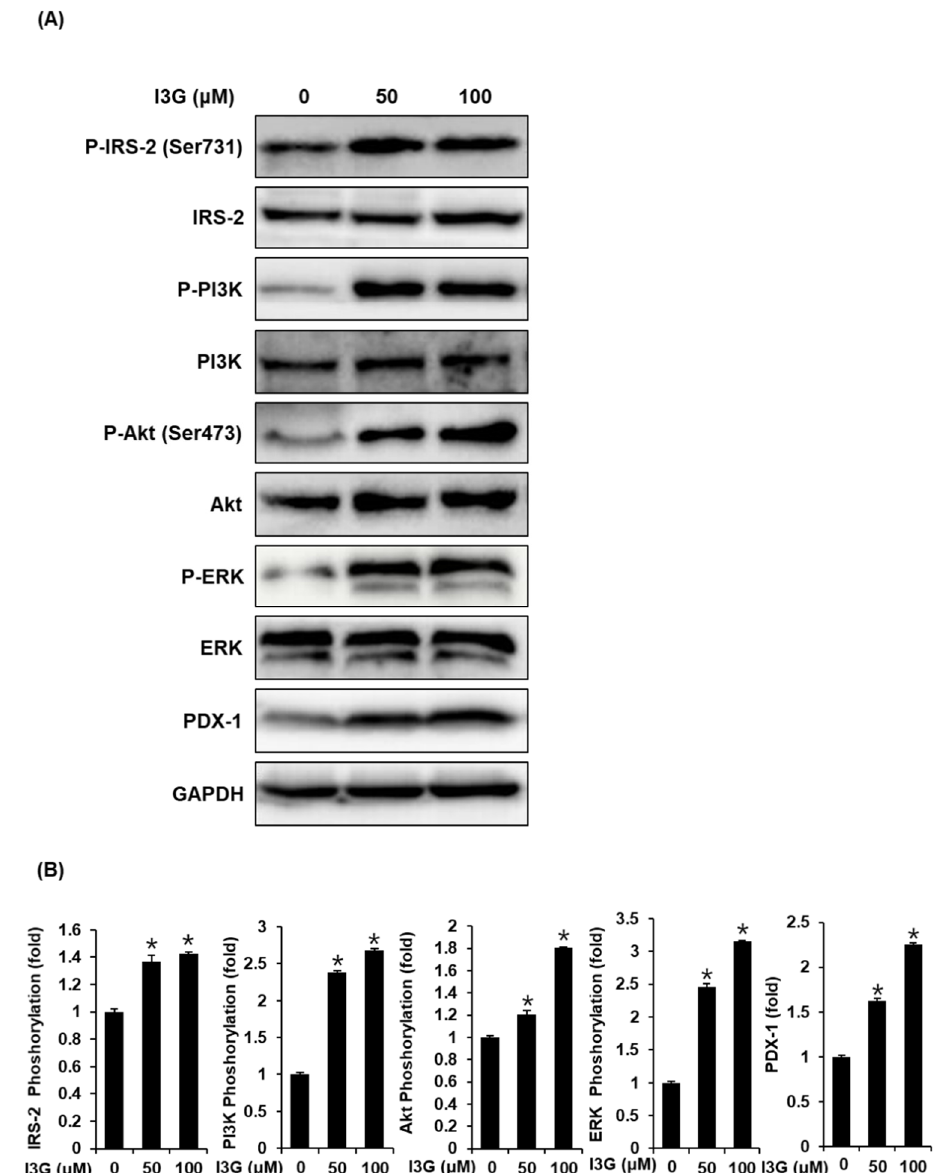
Figure 4. ( A ) Protein expression levels of phospho-insulin receptor substrate-2 (P-IRS-2) (Ser731), IRS-2, phospho-extracellular signal-regulated kinase (P-ERK), ERK, phospho-phosphatidylinositol 3-kinase (P-PI3K), PI3K, phospho-Akt (P-Akt) (Ser473), Akt, pancreatic and duodenal homeobox-1 (PDX-1), and glyceraldehyde 3-phosphate dehydrogenase (GAPDH) in INS-1 cells treated with 50 or 100 µ M isorhamnetin 3- O -glucoside (I3G), or untreated for 24 h. ( B ) Bar graphs present the densitometric quantification of western blot bands ( n = 3 independent experiments, * p < 0.05, Kruskal–Wallis nonparametric test). Data are expressed as the mean ± SEM.